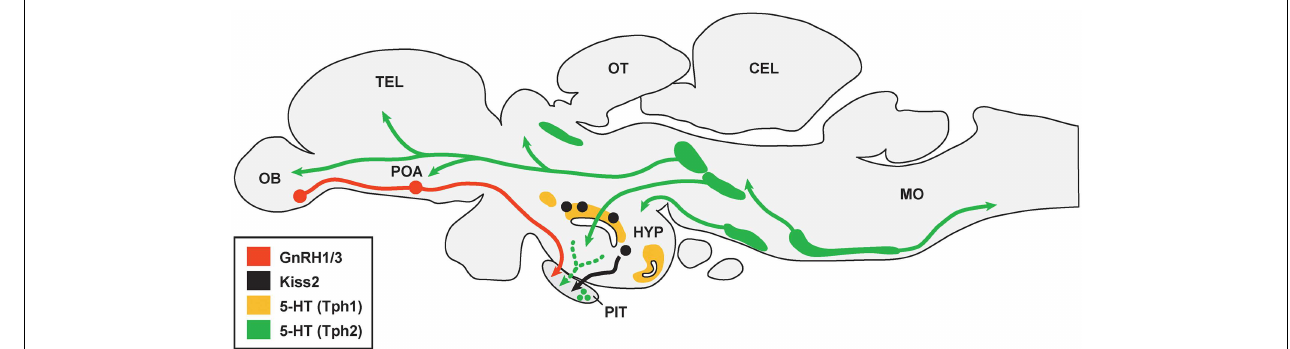
FIGURE 1 | Schematic drawing illustrating association between serotonergic cell populations with GnRH and kisspeptin neurons in the brain of teleosts. There are multiple serotonergic (5-HT) cell populations that express either Tph1 (area shaded with yellow ) or Tph2 (area shaded with green ). 5-HT fibers may project to gonadotropin-releasing hormone (GnRH1 and GnRH3) neurons (shown in red ) in the olfactory bulb (OB) and preoptic area (POA), while it is